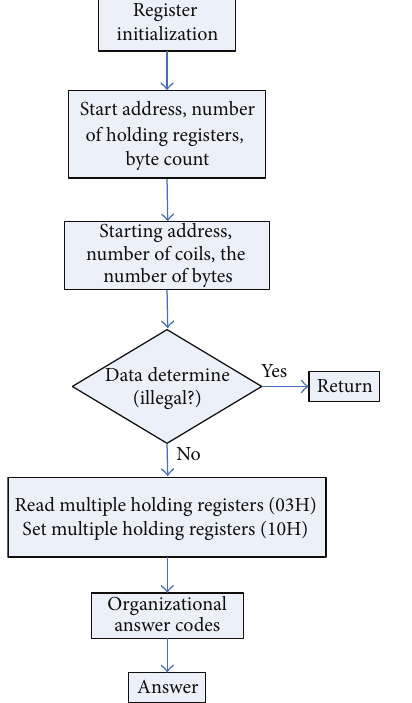
Figure 2: The subroutine structure diagram. Figure 3: Flow chart of read and write holding register communi- cation interruption.